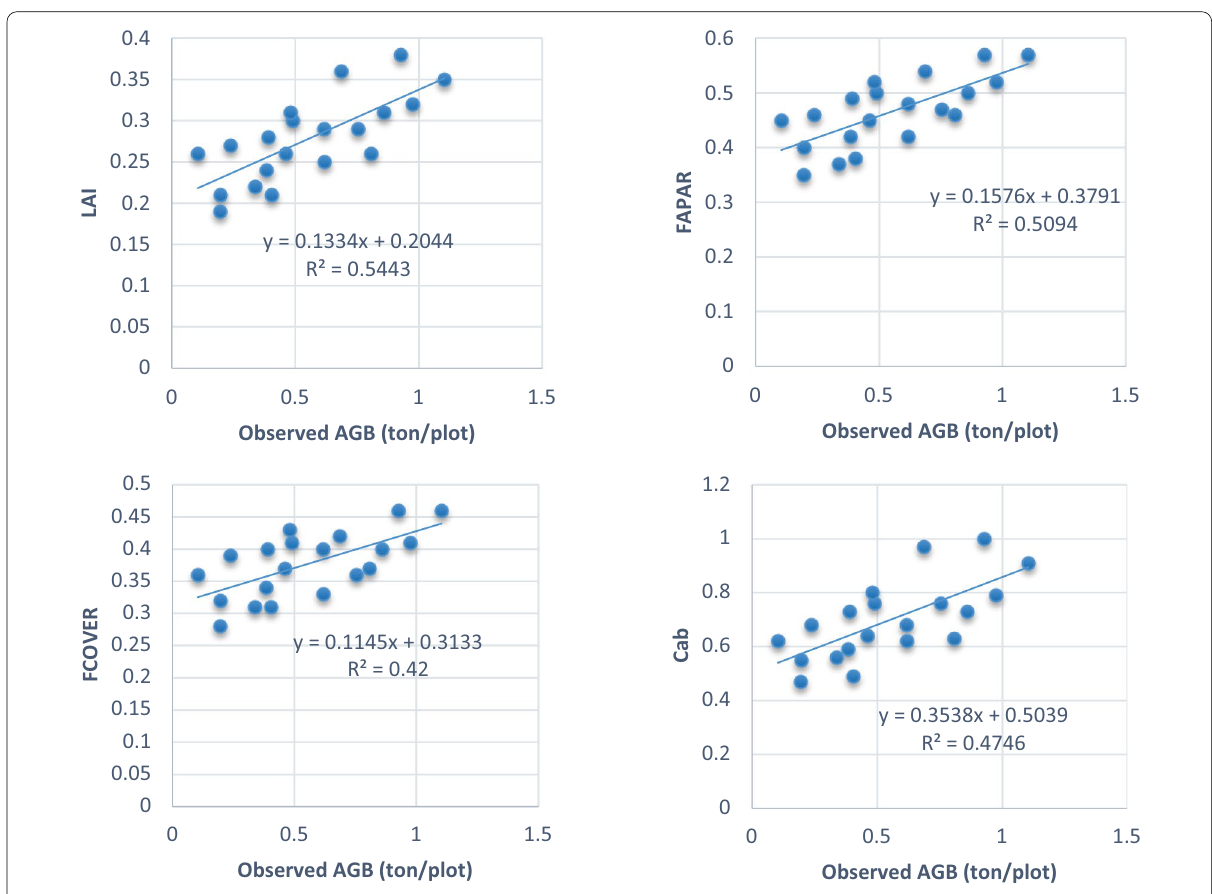
Fig. 9 Linear relationship between observed AGB and vegetation biophysical variables extracted from Sentinel-2 MSI